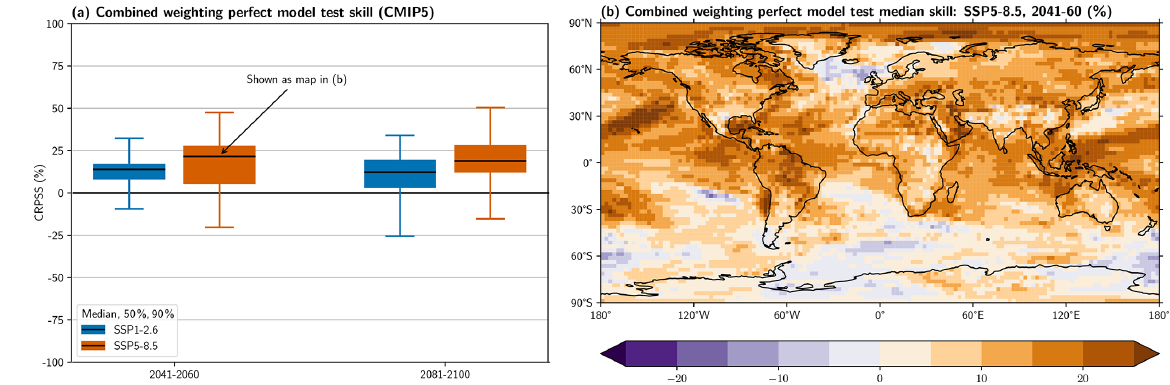
Figure 3. (a) Similar to Fig. 1 but using 27 CMIP5 models as pseudo-observations and showing only the 50% tasTREND case. (b) Map of the median of the CRPSS relative to the unweighted ensemble for 2041–2060 under